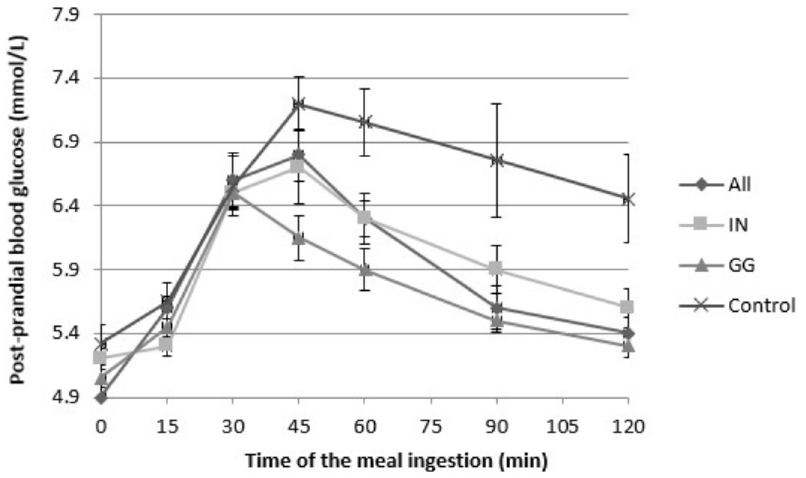
Figure 2. The glycaemic response for Tandoori breads. Table 3. Area under curve, glycaemic and satiety indices of Pita and Tandoori